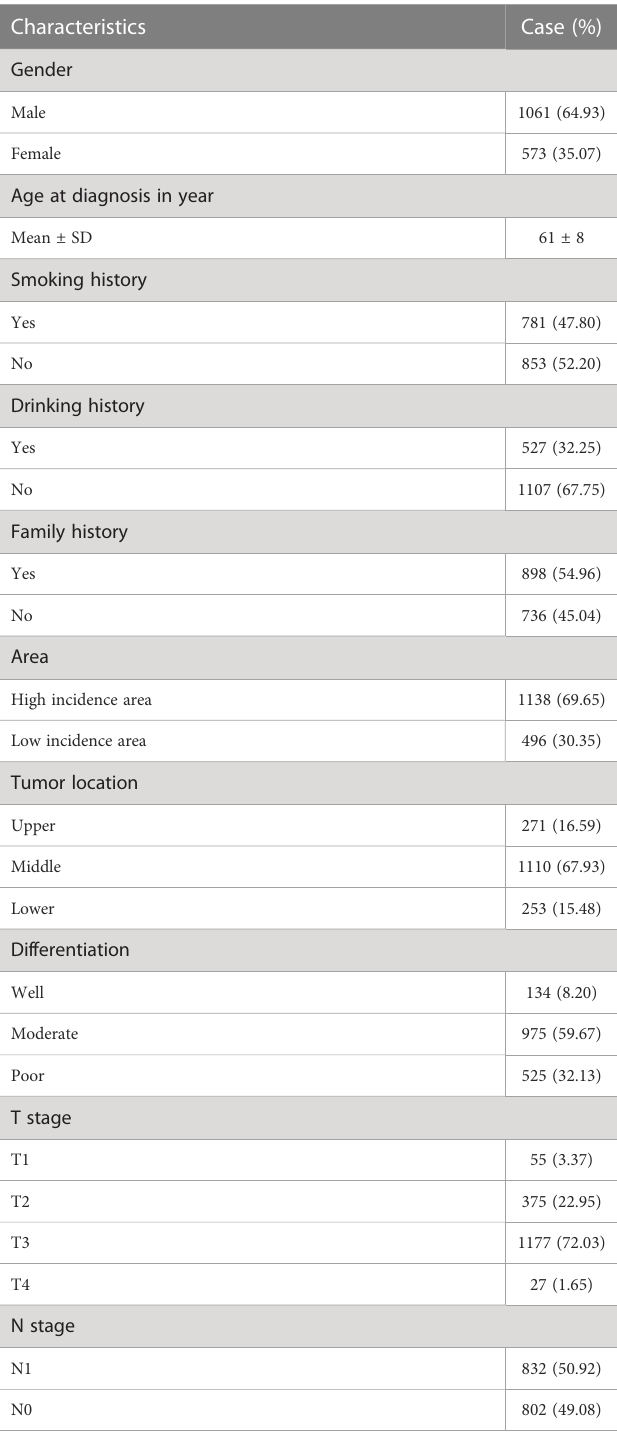
TABLE 1 Clinical characteristics of patients with esophageal squamous cell carcinoma.